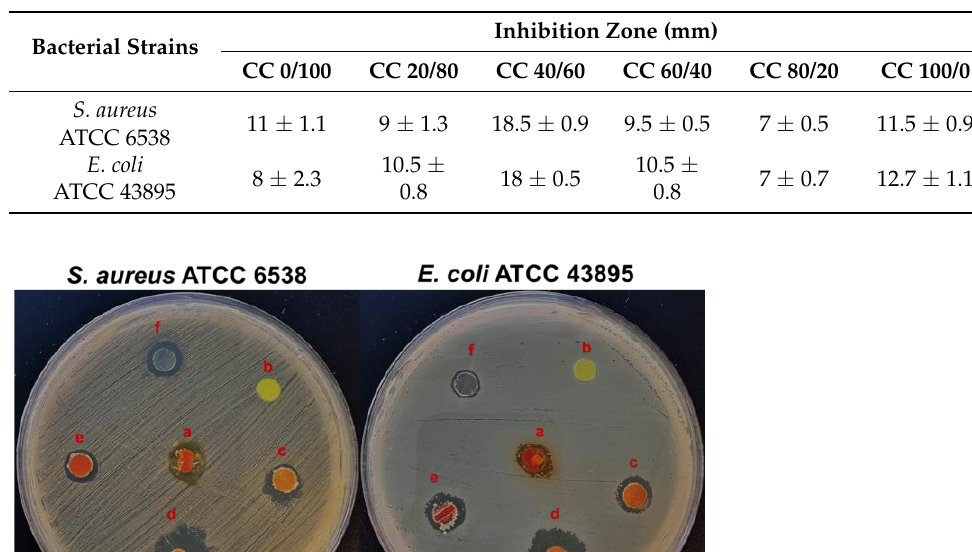
Table 2. Antibacterial activity as indicated by growth-inhibition zone of poly (Ch/C-fu) at concentra- tion of 200 µg/mL against S. aureus and E. coli .